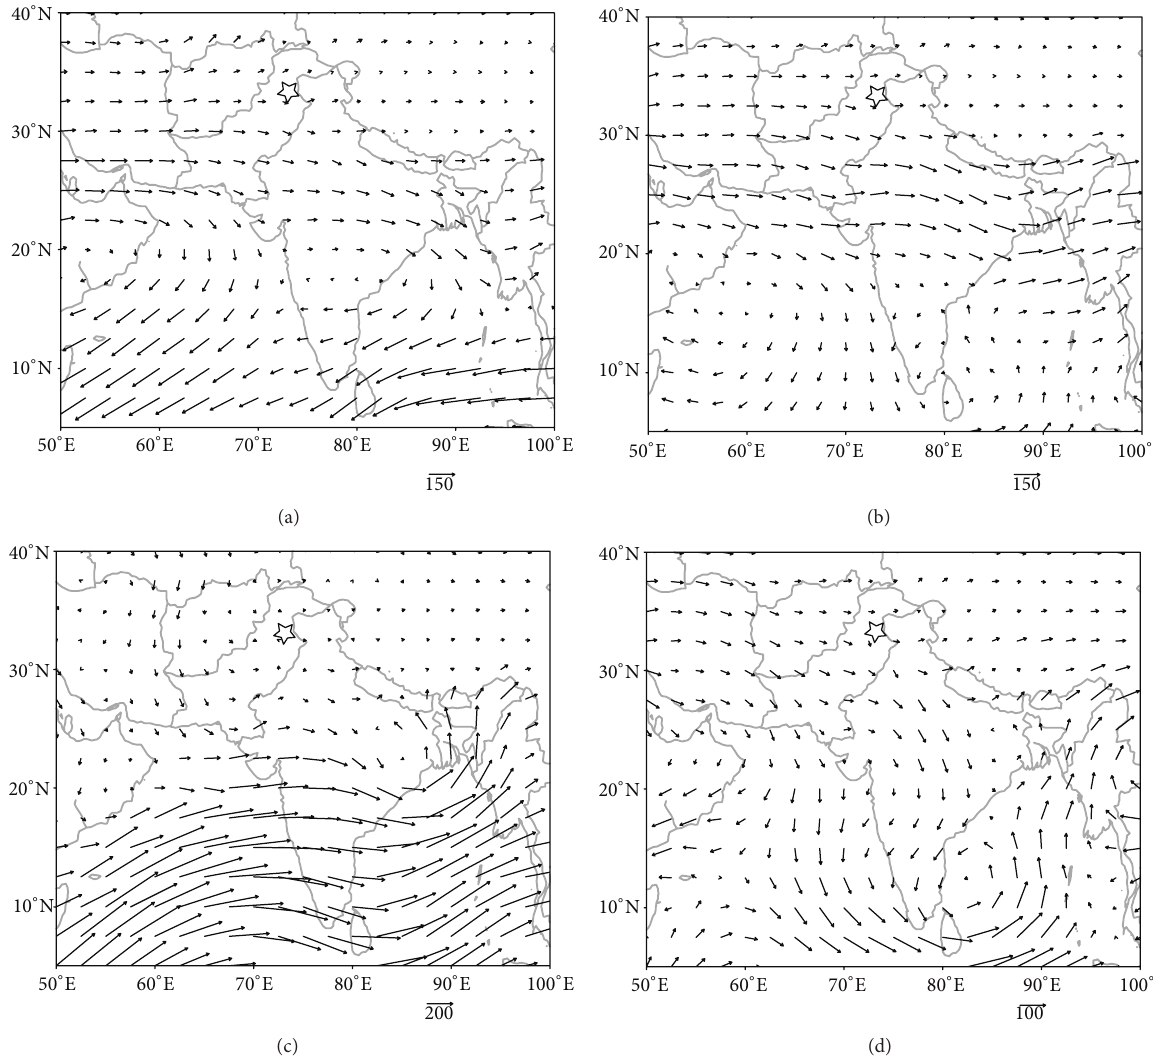
Figure 1: Seasonal vertically integrated water vapor flux (300–1000 hpa) from 1992 to 2006 during (a) winter, (b) spring, (c) summer, and (d) autumn (units: kg ⋅ m −1 ⋅ s −1 ). A star is showing Islamabad (33.65 ∘ N, 73.26 ∘